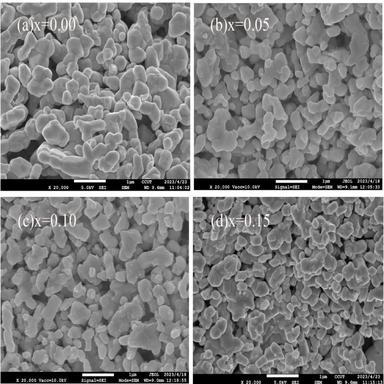
FE-SEM image after calcination in air at 1100 ◦C of La2Ni1-xScxO4+δ: (a) x = 0.00, (b) x = 0.05, (c) x = 0.10 and (d) x = 0.15.